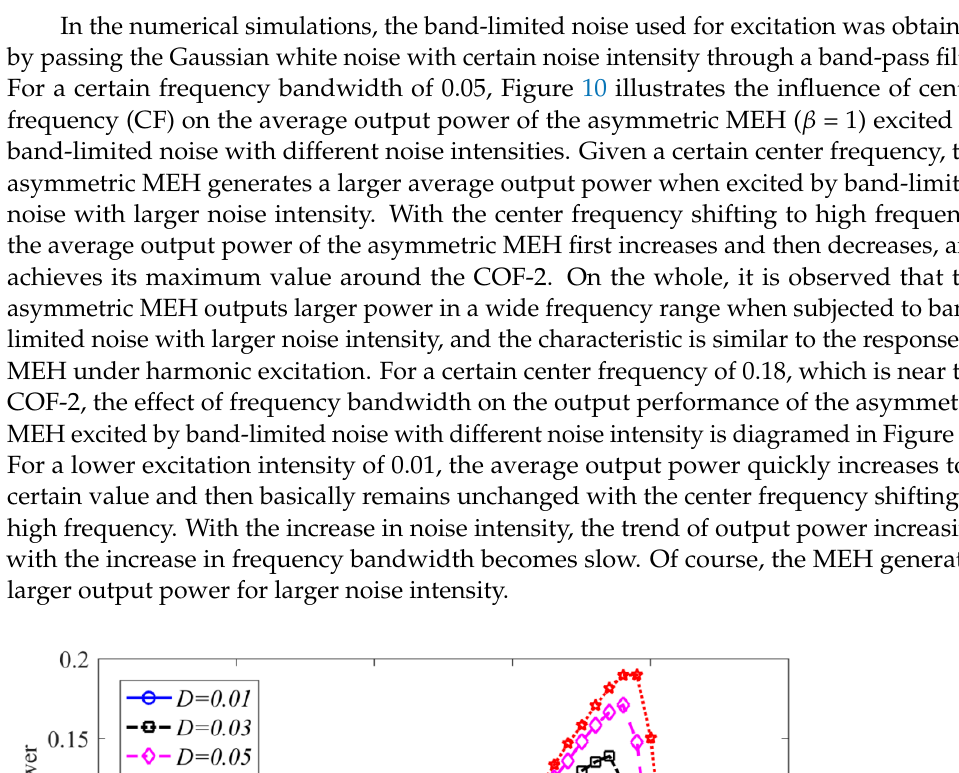
Figure 9. Influence of quadratic coefficient on the response frequency band of the asymmetric MEH under harmonic excitation with a level of 0.2: ( a ) up-sweep frequency; ( b ) down-sweep frequency.